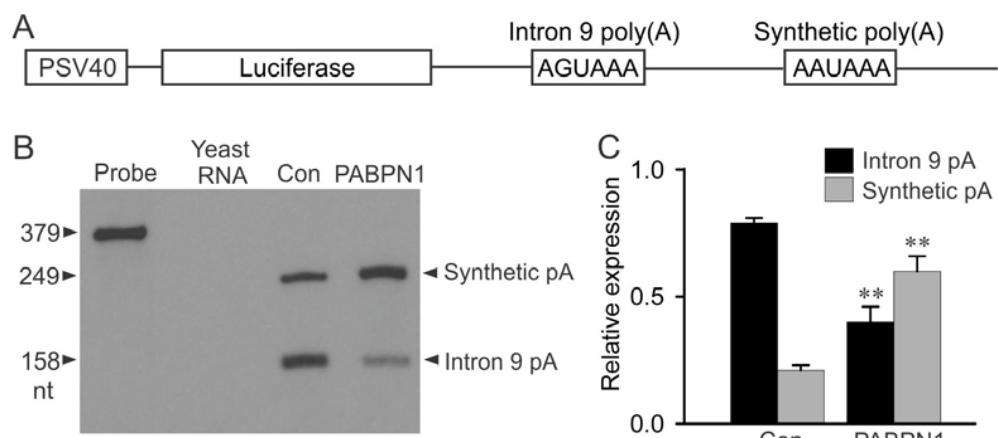
Figure 2. Suppression of the KCNH2 intron 9 poly(A) signal by PABPN1. ( A ) Diagram of the tandem poly(A) signal construct including the SV40 promoter, firefly luciferase gene, KCNH2 intron 9 poly(A) signal and the strong, synthetic poly(A) signal. ( B ) RNase protection assay (RPA) analysis of the relative usage of intron 9 poly(A) signal and synthetic poly(A) signal following the co-transfection of HEK293 cells with the tandem poly(A) signal construct and vector control (Con) or with PABPN1. Yeast RNA was used as a control for the complete digestion of the probes by RNase. ( C ) Histogram plotted as the expression of intron 9 poly(A) and synthetic poly(A) relative to the total intron 9 poly(A) + synthetic poly(A) signal. The activity of the intron 9 poly(A) signal significantly decreased following co-transfection with PABPN1 compared with vector-transfected control (black bars) and the activity of the synthetic poly(A) signal significantly increased following co-transfection with PABPN1 compared with vector-transfected control (gray bars) (**, p < 0.01, n = 3, mean ± S.E.).